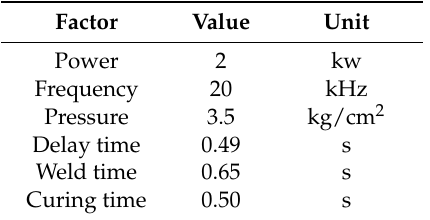
Table 1. Ultrasonic strengthening parameters.